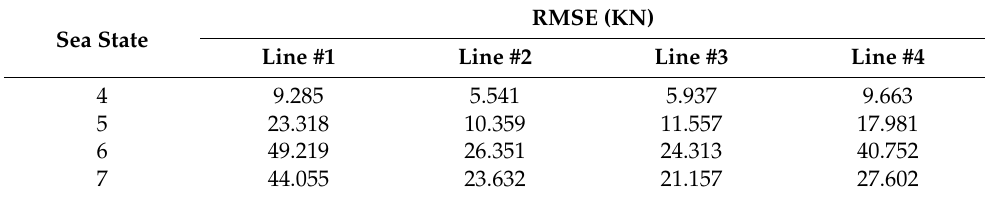
Table 5. The RMSE of prediction results under sea states